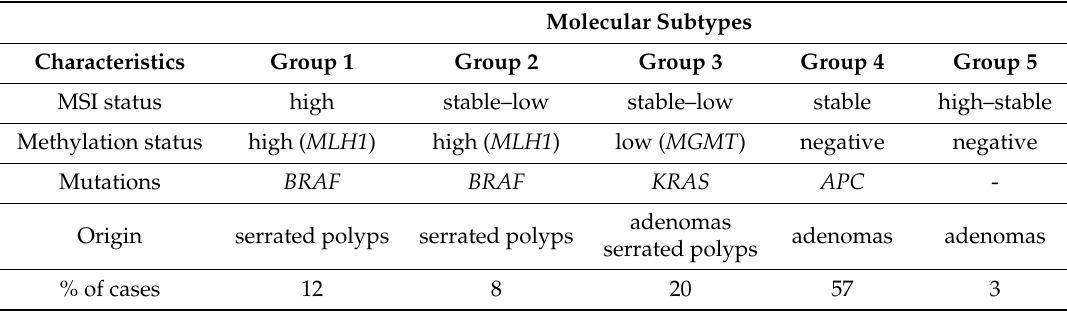
Table 1. Molecular stratification by Jass et al. [123]. Molecular